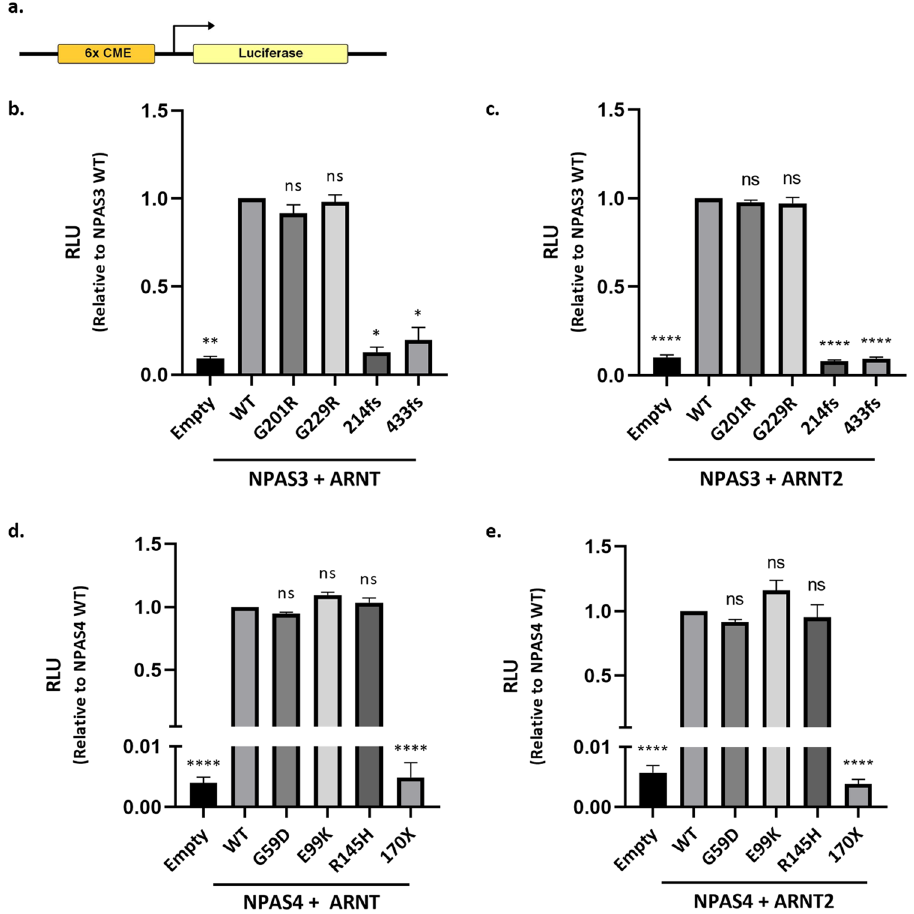
Figure 2. Identification of variants with deficient activity. ( a ) The firefly luciferase reporter gene construct utilised to assess NPAS3 and NPAS4 variant activity. The reporter contains an upstream CME site able to be bound by both NPAS3 and NPAS4. All experiments also incorporated renilla luciferase under a constitutive promoter as an internal control. ( b–e ) To test variant activity, HEK293T cells were transiently transfected with the 6 × CME firefly luciferase plasmid, the constitutive renilla luciferase plasmid, and expression plasmids for the NPAS3/4 variant and either ARNT or ARNT2 . No dimer-specific effects were observed for either NPAS3 or NPAS4. For NPAS3 only the frameshift mutations (214fs and 433fs) had deficient activity ( b , c ). For NPAS4 only the nonsense variant (170 ×) had deficient activity ( d , e ). All graphs show mean with SEM from at least 3 independent experiments, each performed in triplicate. Significance was calculated by Ordinary One- Way ANOVA with Dunnett’s multiple comparison test on log-transformed raw data (*p < 0.05, **p < 0.01, ****p < 0.0001). RLU —Relative Luciferase Units, WT —wildtype, ns —not